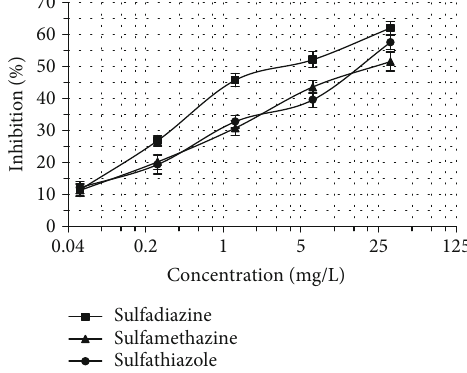
Values are mean ± SD ( n = 3 ).